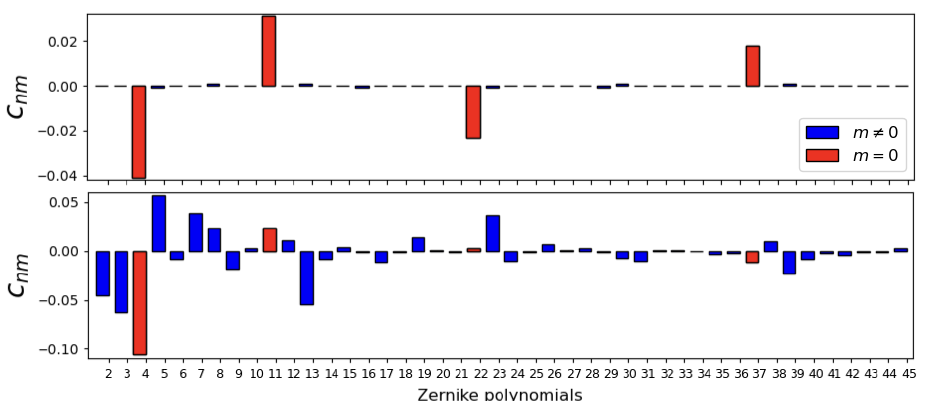
Figure 1. Zernike coe ffi cients c nm computed by fitting y -maps of a relaxed (top) and a disturbed (bot- tom) cluster. Red bars refer to ZPs with m = 0, while blue bars are for m , 0. The ZPs are ordered by following the Noll’s scheme [6]. Note that the first term ( Z 0 ) is neglected because the corresponding 0 c 00 is simply equal to the mean value of the signal inside the circular aperture in the map.